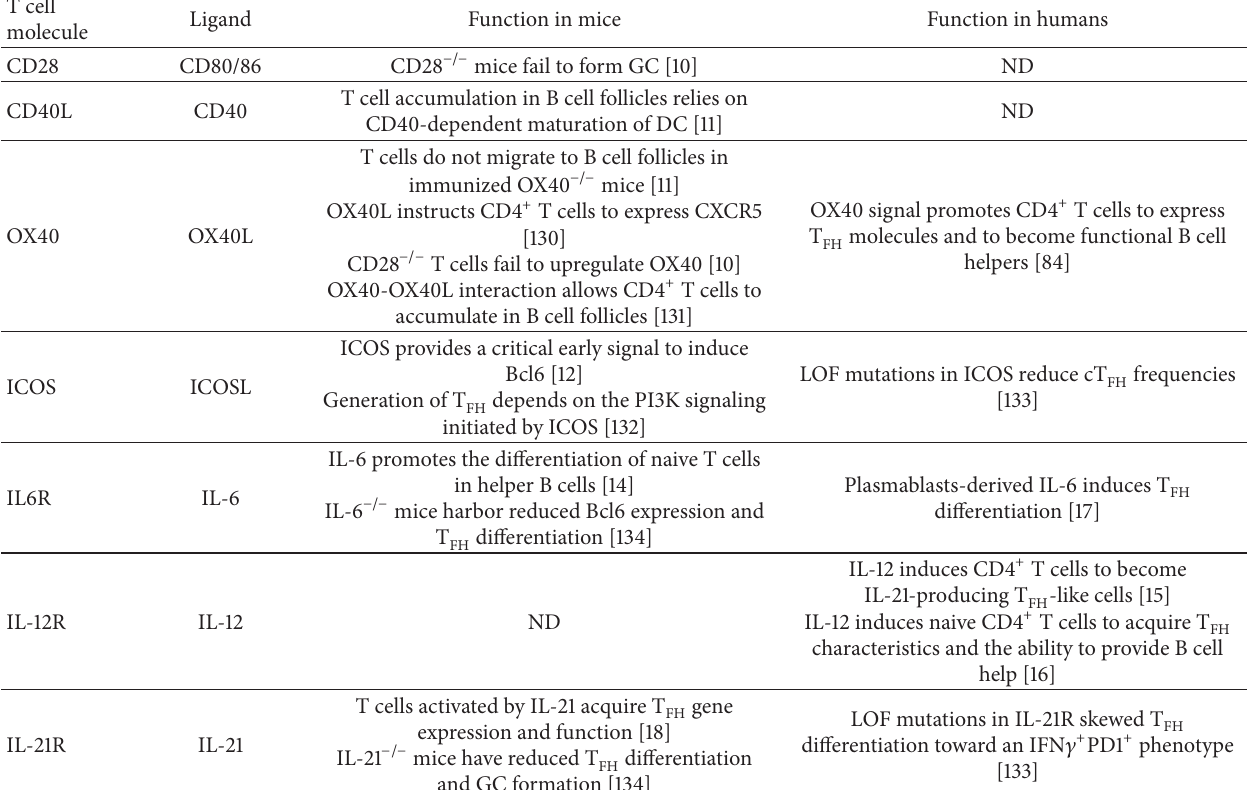
-related molecules during T FH